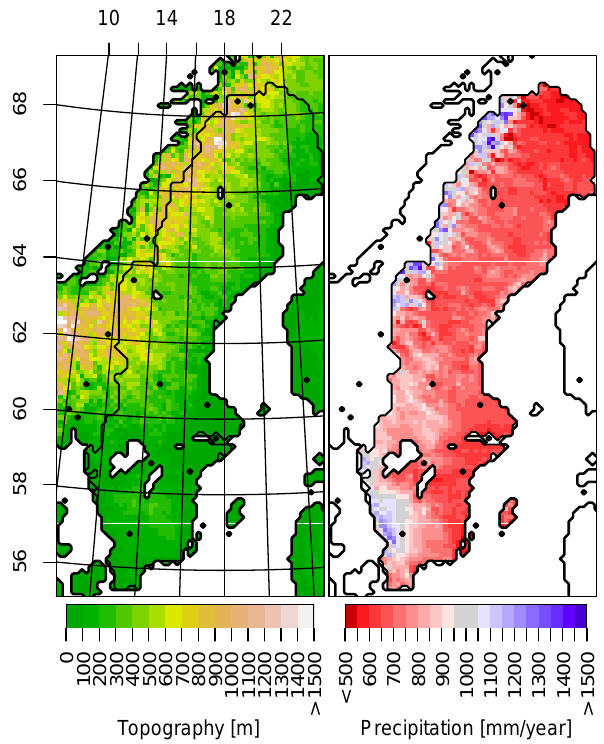
Figure 1. Topographical map of Sweden and its near surroundings ( left ). Mean annual precipitation for the period 1980–2009 from the PTHBV data set at the RCA model resolution of about 12.5 km ( right